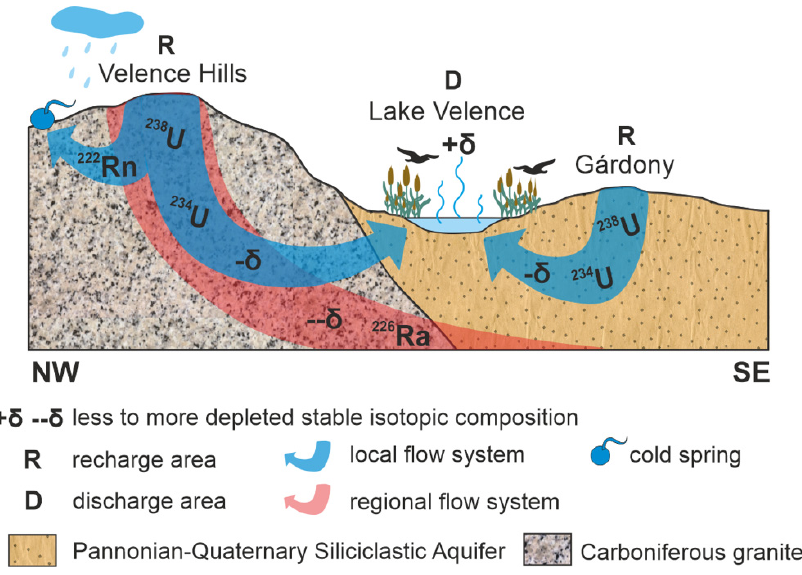
Figure 8. Conceptual model of integration of Lake Velence into the groundwater flow